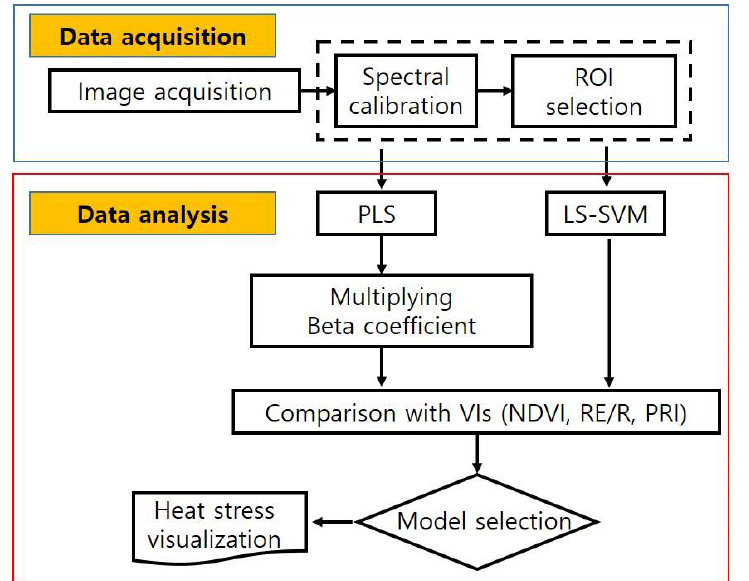
Figure 2. Workflow of the image processing process for heat stress visualization. ROI, region of interest; PLS, partial-least squares; LS-SVM, least-squares support vector machine; VI, vegetation index; NDVI, normalized difference vegetation index; RE/R, red-edge ratio; PRI, photochemical reflectance